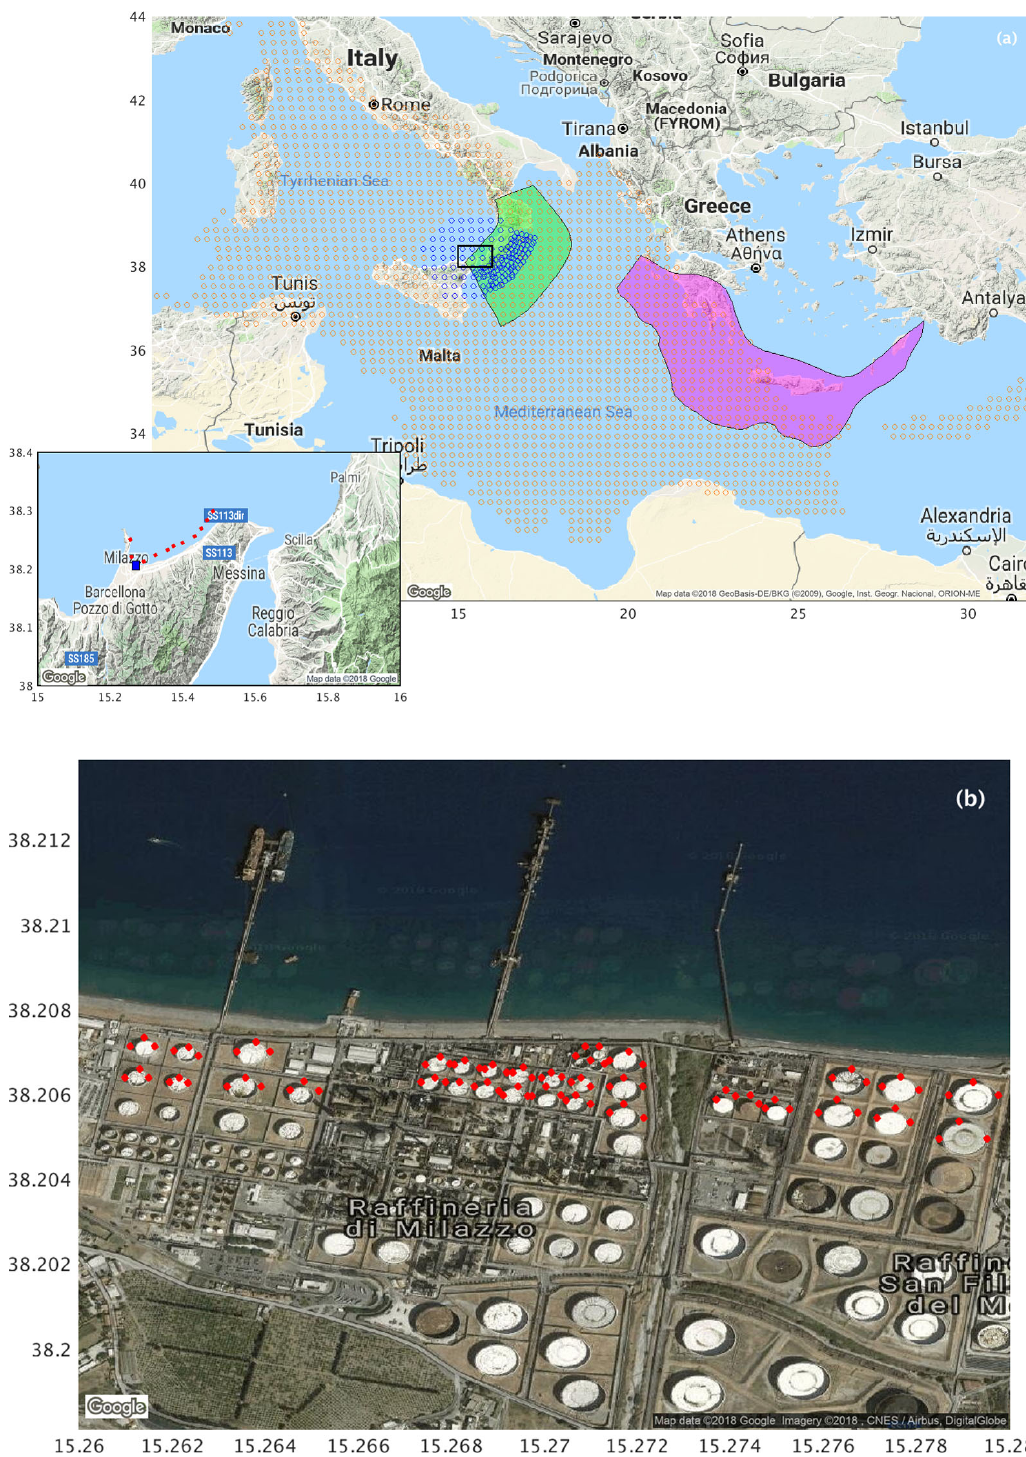
Figure 2. (a) Map of the whole simulation domain used for the application at the target site Milazzo (Sicily, Italy). The orange circles are the geometrical centers of the crustal faults affecting the target site, while the magenta and the green regions are the slab models of the Hellenic and Calabrian arcs, respectively. Blue circles are the geometrical centers of the near-field sources, as detected in step (3b) (see text). The inset highlights the offshore points along the 50m isobath (red points). The blue square within the inset is the area displayed in the bottom panel. (b) Zoom of the Milazzo oil refinery, with the position of the 95 points at the edges of the storage tanks (red